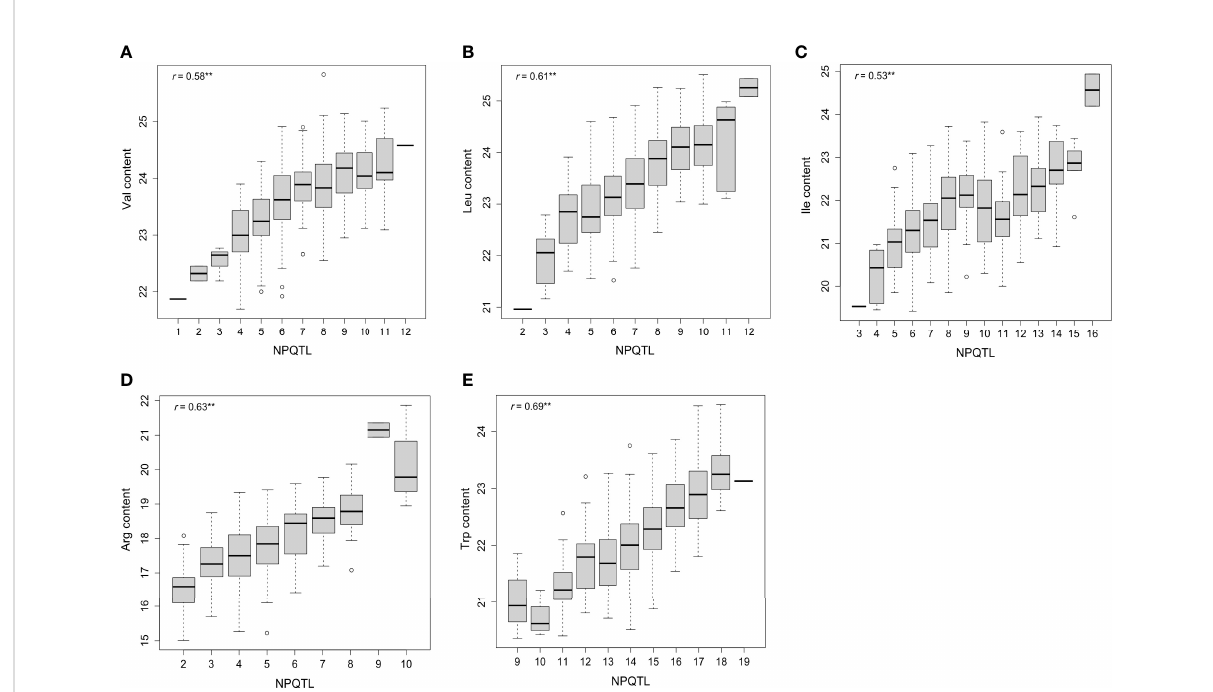
FIGURE 5 Box plots of the number of stable QTL with positive-effect alleles (NPQTL) in relation to Val, Leu, Ile, Arg, and Trp contents (A – E) . ** indicates statistical signi fi cance at the 1% probability